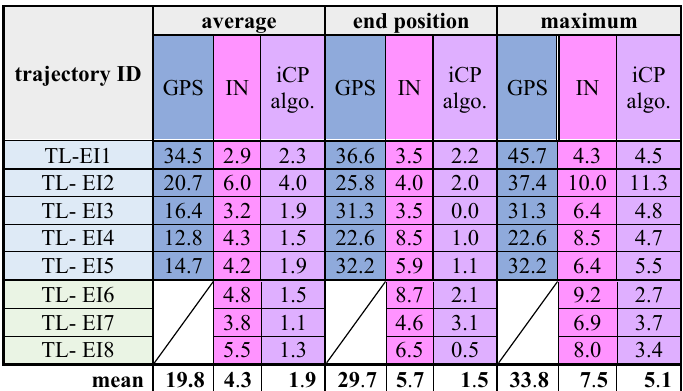
Table 3. Detailed deviations in [m] and comparison for GPS, IN and iCP